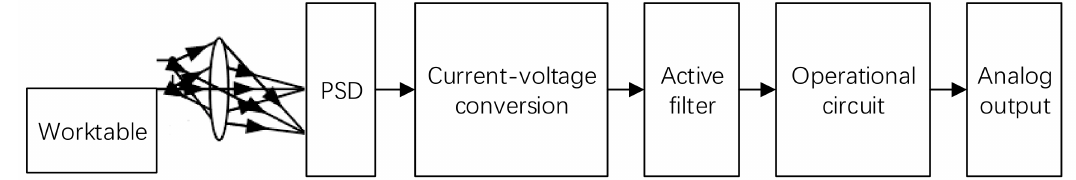
Figure 3. Schematic diagram of the PSD displacement detection system.